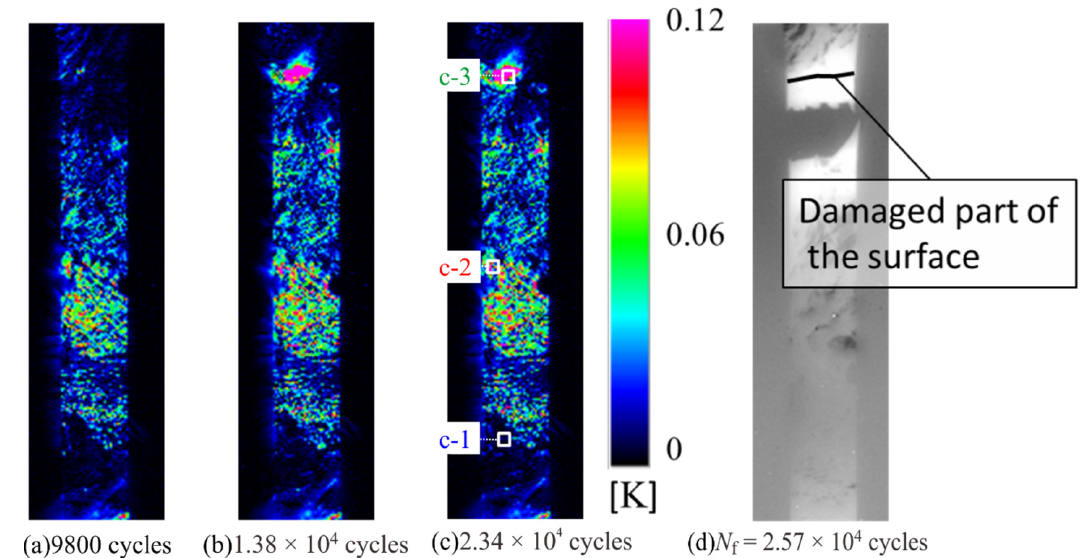
Figure 12. Second harmonic temperature component measured at different timings with σ max = 100 MPa, measured at ( a ) N = 9800 cycles, ( b ) N = 1.38 × 10 4 cycles, ( c ) 2.34 × 10 4 cycles, and ( d ) infrared image at N f = 2.57 × 10 4 cycles.